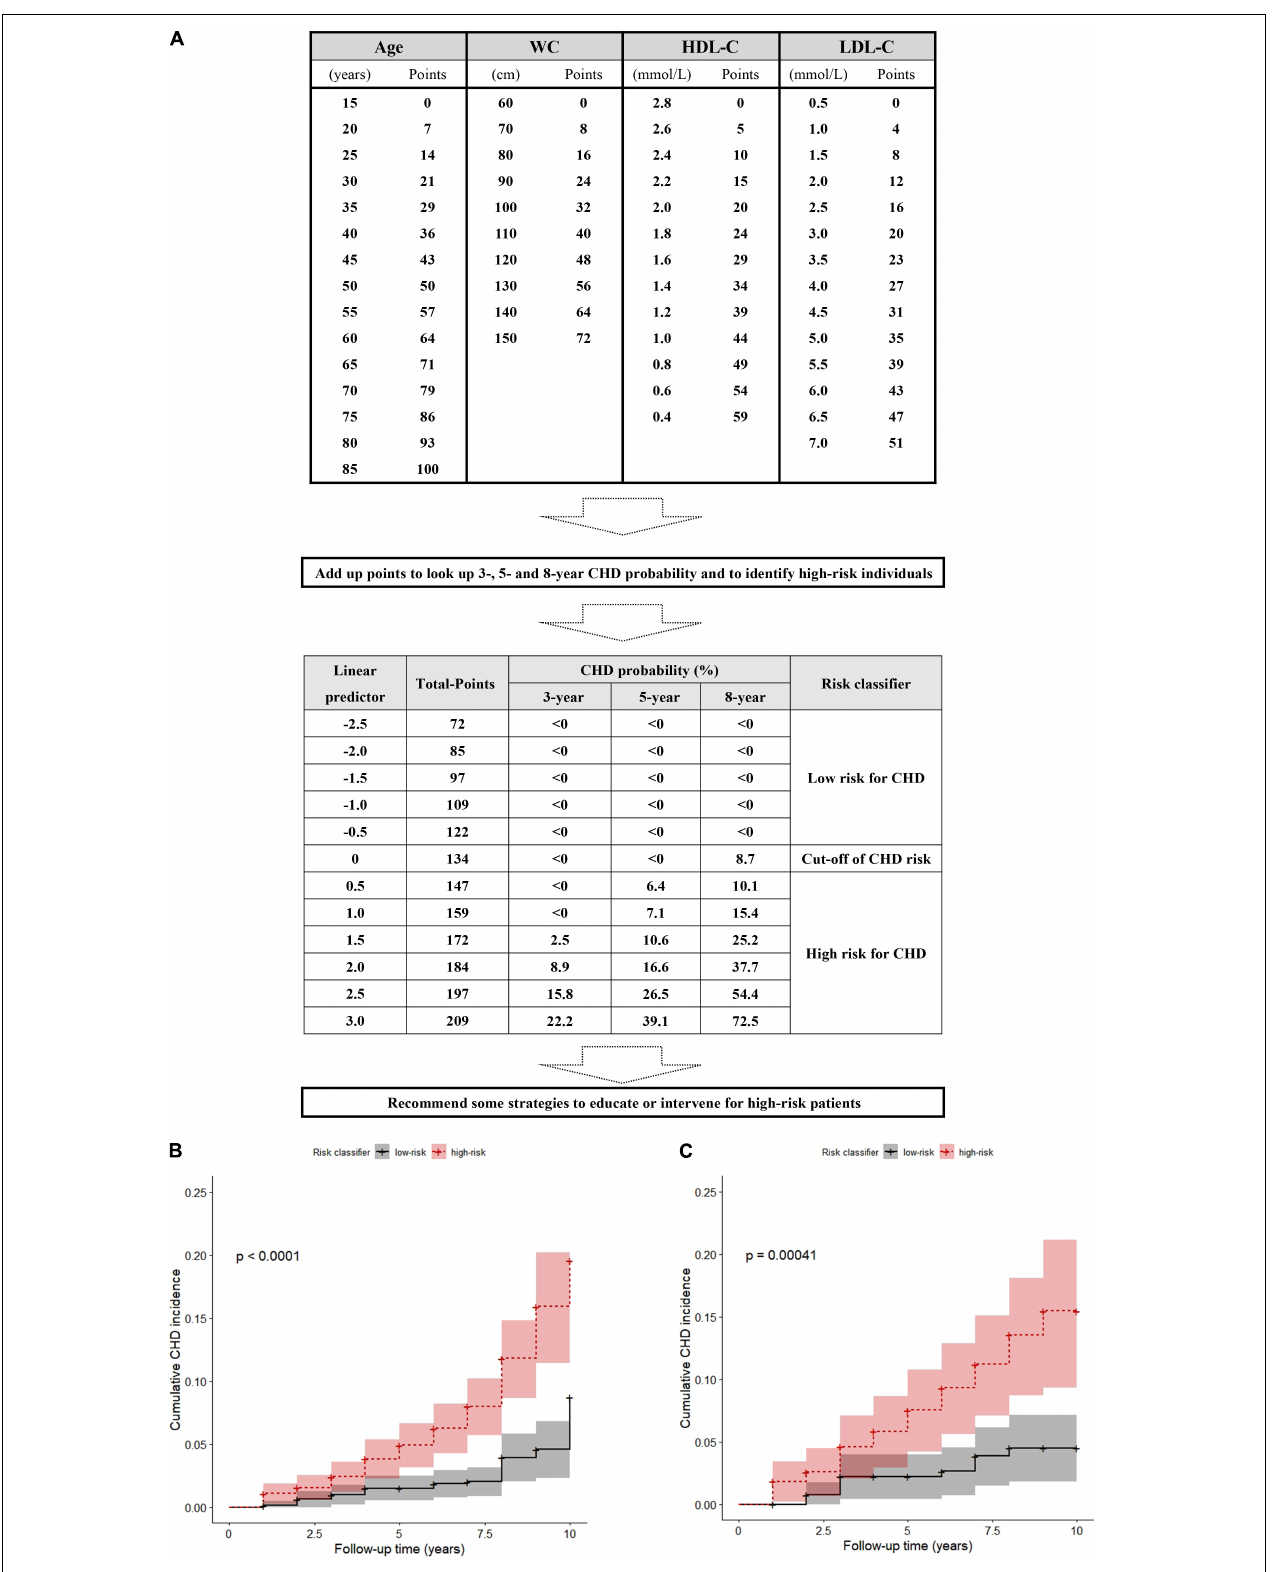
FIGURE 3 | A score sheet and risk classifier to identify high-risk patients for CHD in snorers with uncontrolled hypertension (A) , and the cumulative incidences after risk stratification in the training set and (B) in the validation set (C) .